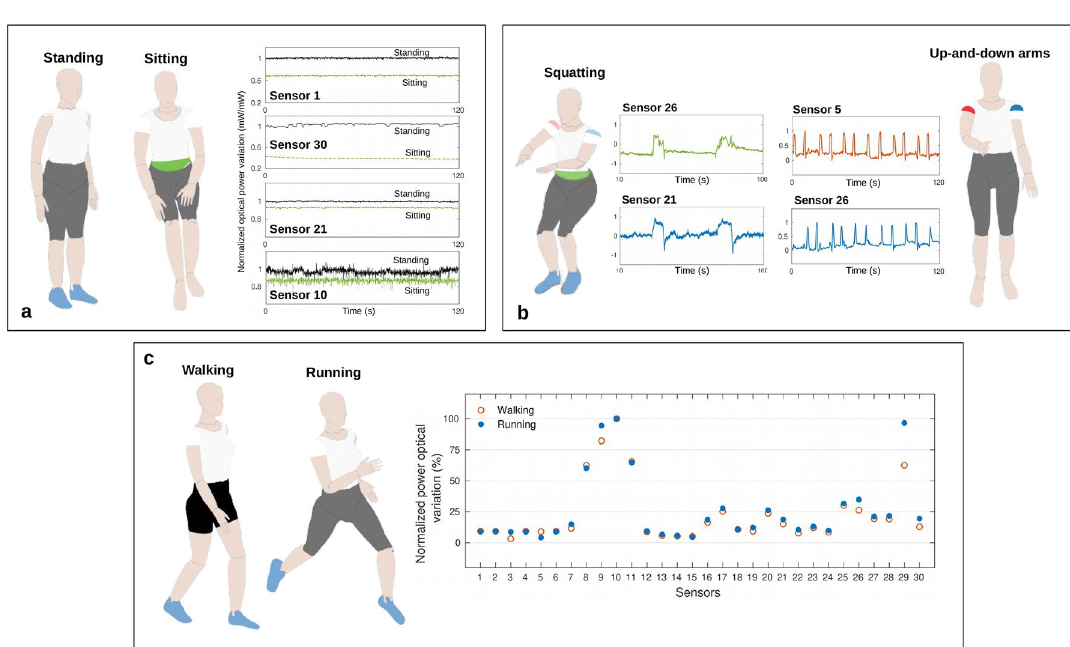
Figure 5. Sensors activation for each activity. ( a ) Optical power variation between the standing and sitting activities of sensors 1, 30, 21 and 10. ( b ) Response of sensors 26 and 21 during the squatting activity and response of sensors 5 and 26 during the up-and-down arms activity. ( c ) Sensors activation during the walking and running